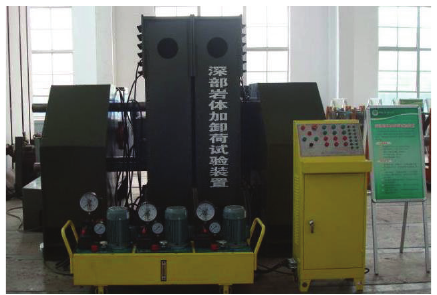
Figure 2: Deep rock mass loading and unloading test apparatus.